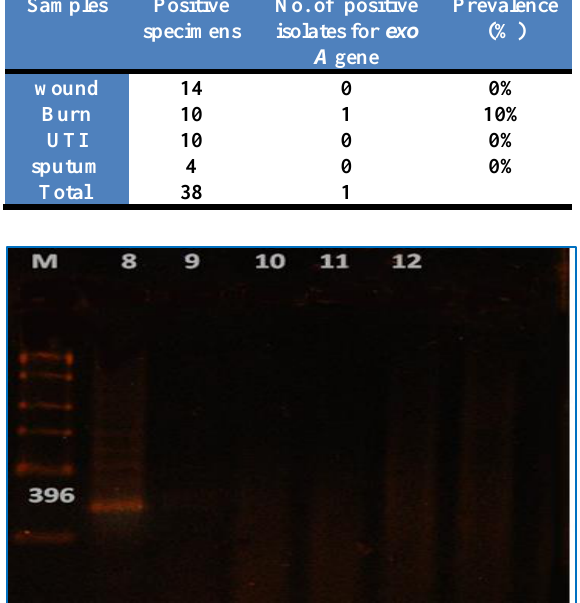
Figure, 2: Agarose gel electrophoresis of PCR products for exo A gene. Lanes M: marker ladder 100-bp. Lanes 8: exo A gene with 396